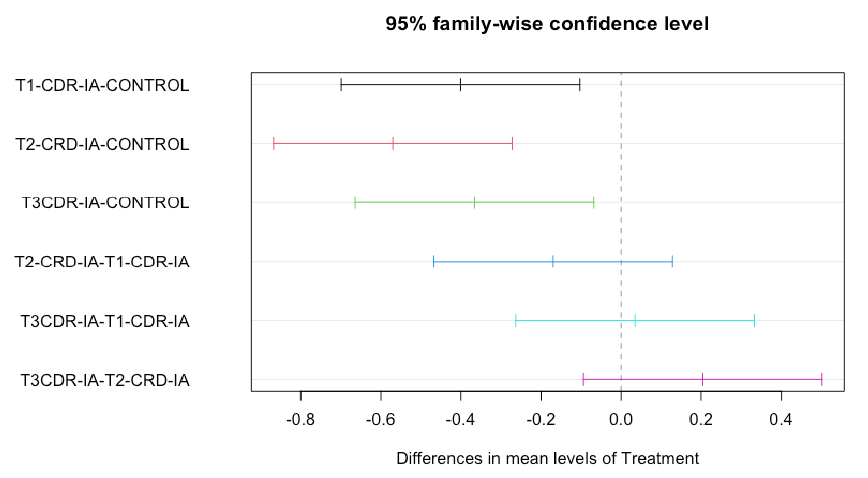
Figure A4. Differences in mean levels of treatment.